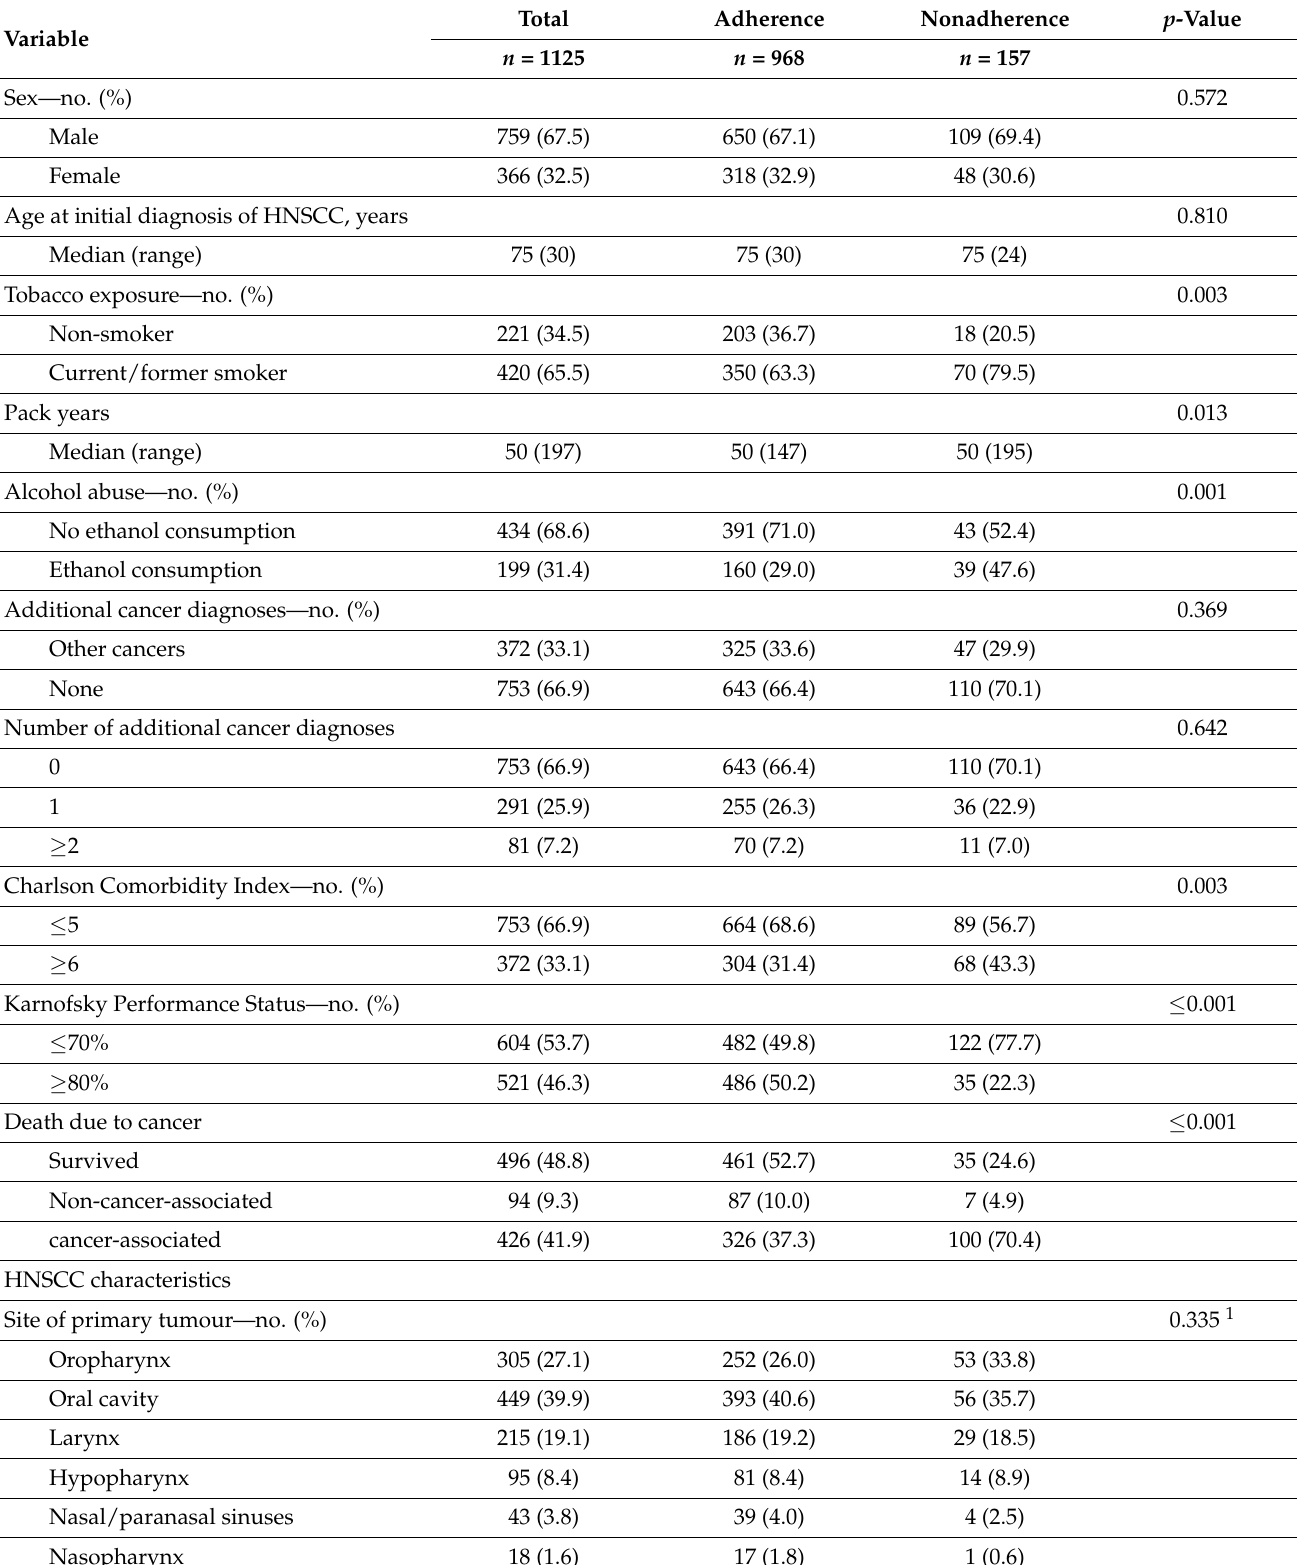
Table 1. Patient and tumour characteristics of the study population according to adher- ence/nonadherence to the tumour board